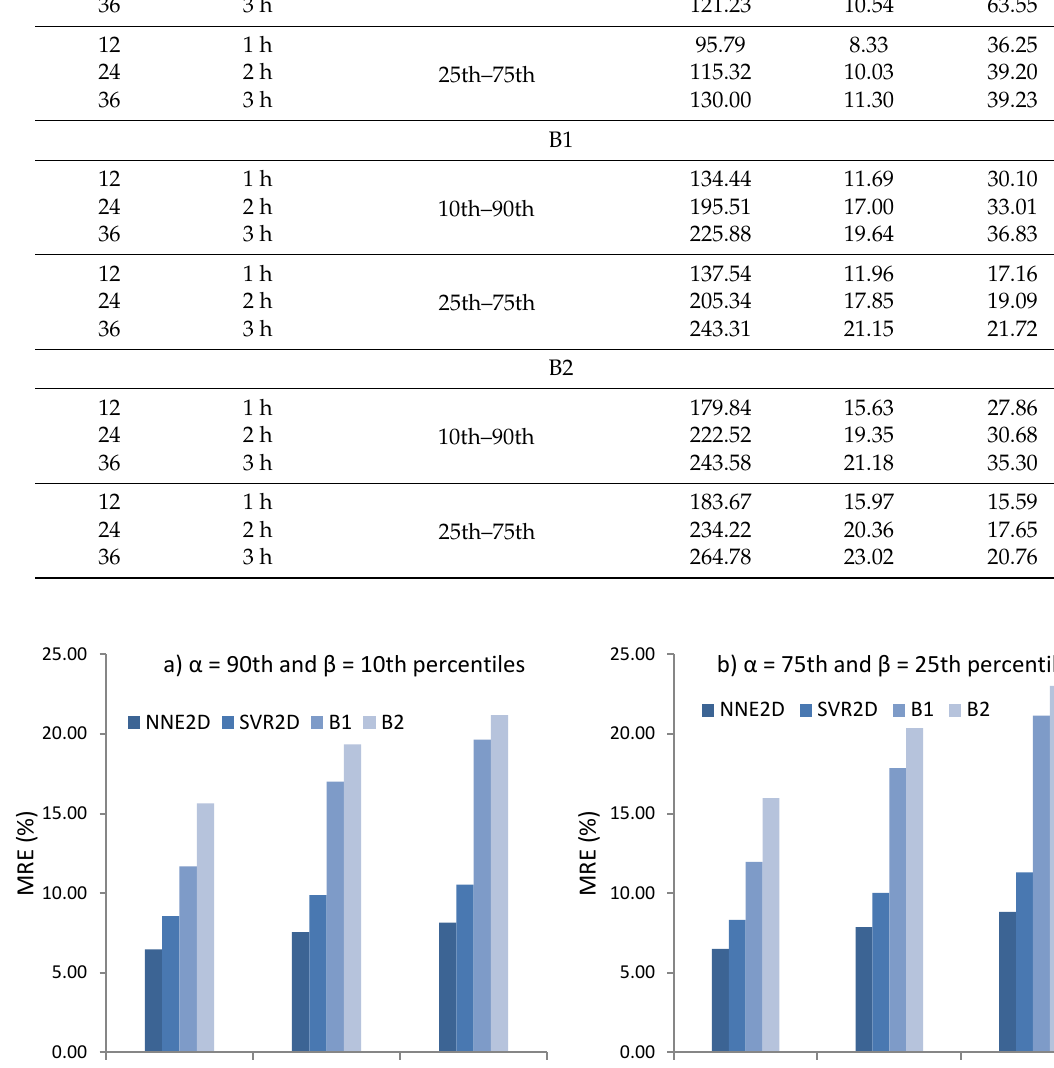
Table 5. Accuracy results for the methods used for comparison: SVR2D, B1 and B2.